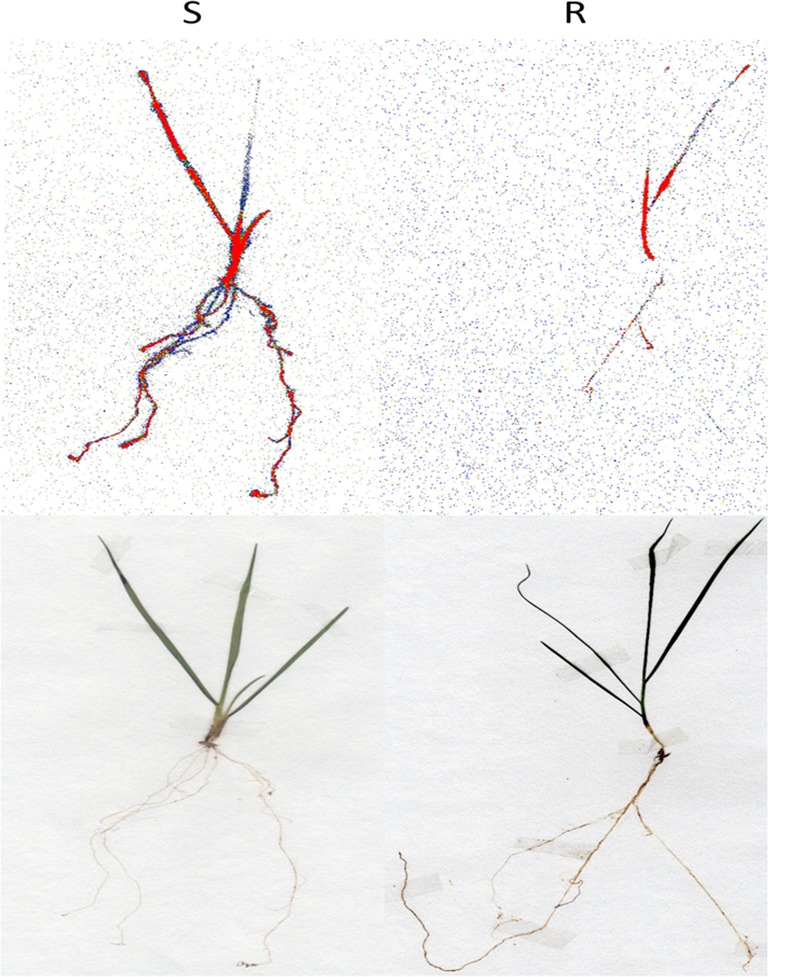
Phosphorimaging visualization of 14C-glyphosate in plants of rigid ryegrass of susceptible (left) and resistant (right) biotypes at 96 h after treatment.